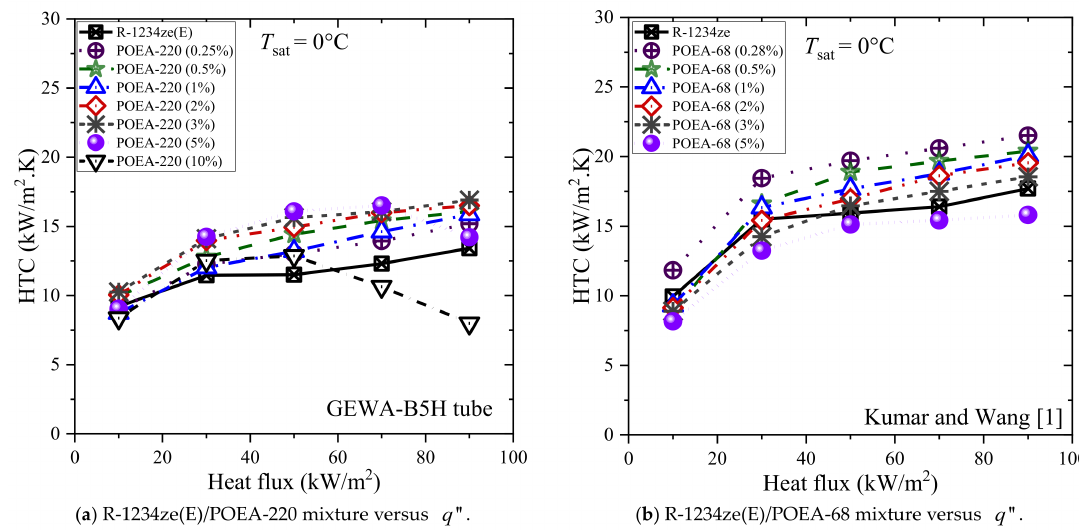
Figure 6. HTC versus q (cid:48)(cid:48) ( a ) R-1234ze(E)/POEA-220 mixture ( b ) R-1234ze(E)/POEA-68 mixture 0 ◦